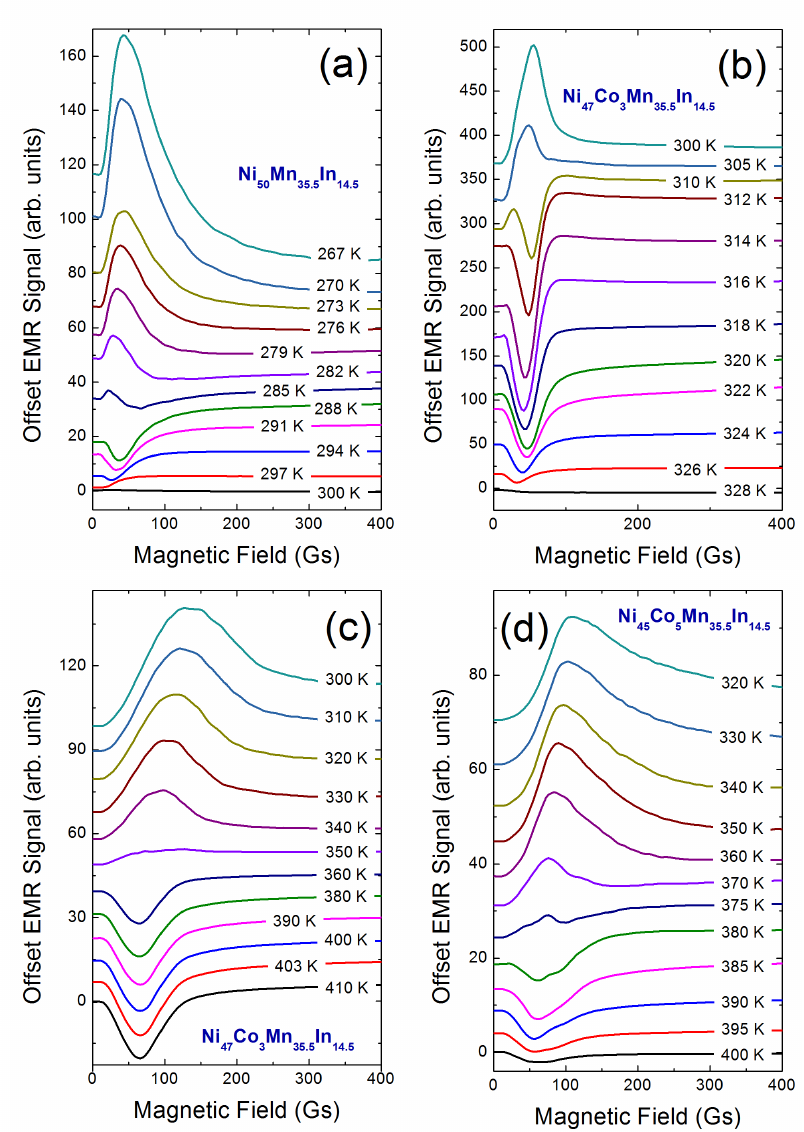
Figure 2. The temperature evolution of LFMA signal for Ni 50 − x Co x Mn 35.5 In 14.5 ribbons: annealed Ni 50 Mn 35.5 In 14.5 ( a ), as-spun Ni 47 Co 3 Mn 35.5 In 14.5 ( b ), annealed Ni 47 Co 3 Mn 35.5 In 14.5 ( c ) and annealed Ni 45 Co 5 Mn 35.5 In 14.5 ( d